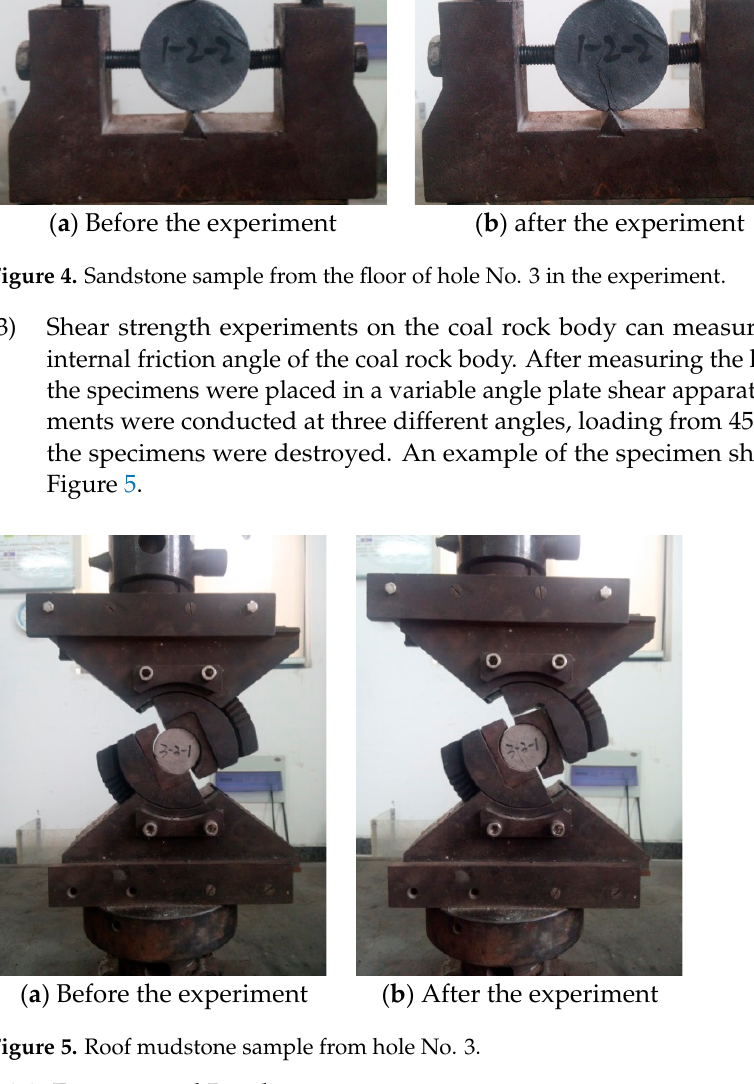
Figure 5. Roof mudstone sample from hole No. 3.